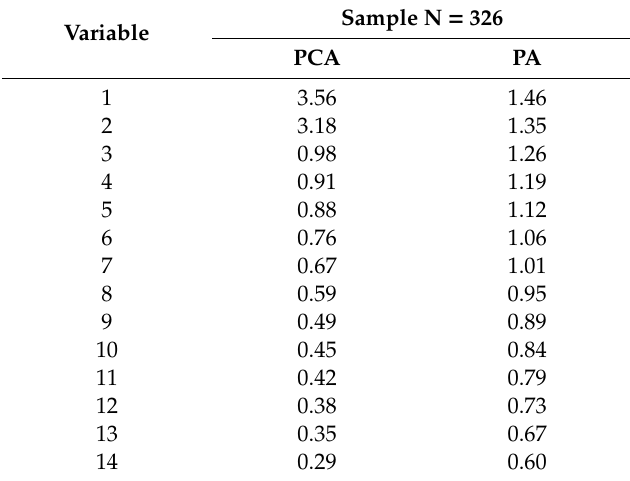
Table 2. Parallel analysis for the Preventive and Proactive Coping with Bad Weather in Outdoor Sports